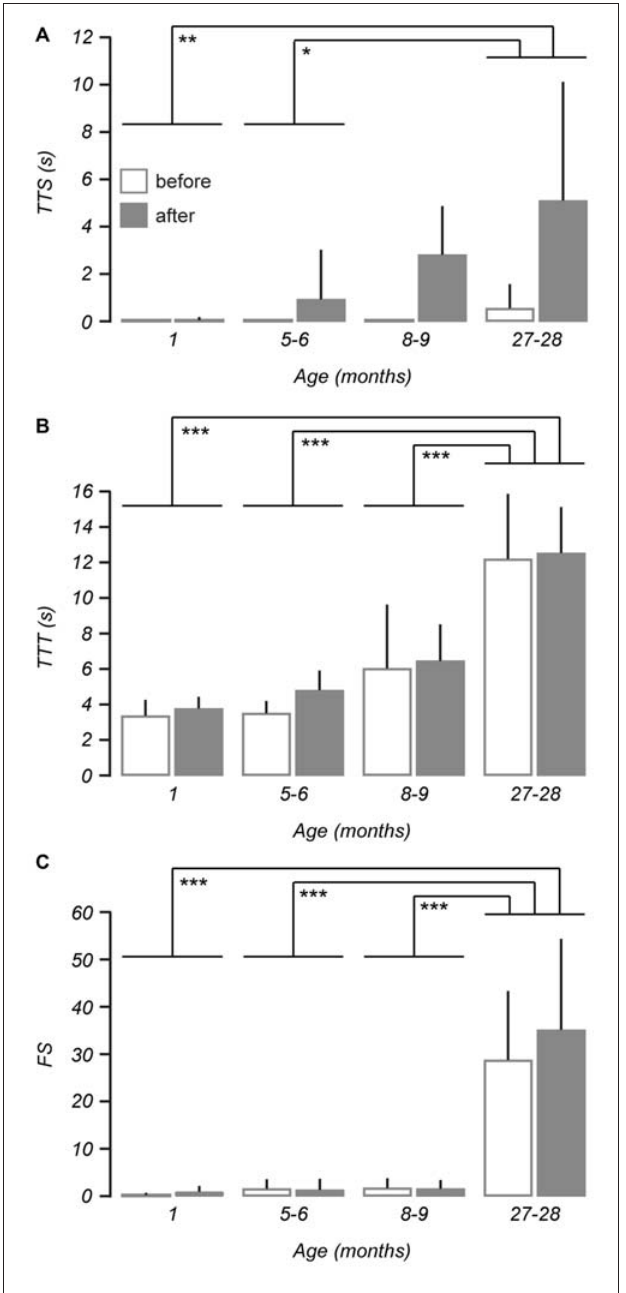
FIGURE 3 | Balance and motor performance is impaired in older mice after vestibular stimulation . Age-related changes were assessed using three different measures of balance beam performance across 1 ( n = 9), 5–6 ( n = 7), 8–9 ( n = 7) and 27–28-month-old mice ( n = 8). (A) The effect of the vestibular stimulus on time to start (TTS) walking was increased with age such that 27–28-month-old mice were more affected than 1-month-old and 5–6-month-old mice. (B) Changes observed in measurements of time to traverse (TTT) as a result of the vestibular stimulus were not age-dependent, however differences were apparent between 27–28-month-old mice and other age groups. (C) An age-related effect of the vestibular stimulus was also identified by the number of foot slips (FS). Error bars = SD , ∗ p < 0.05, ∗∗ p < 0.01, ∗∗∗ p ≤